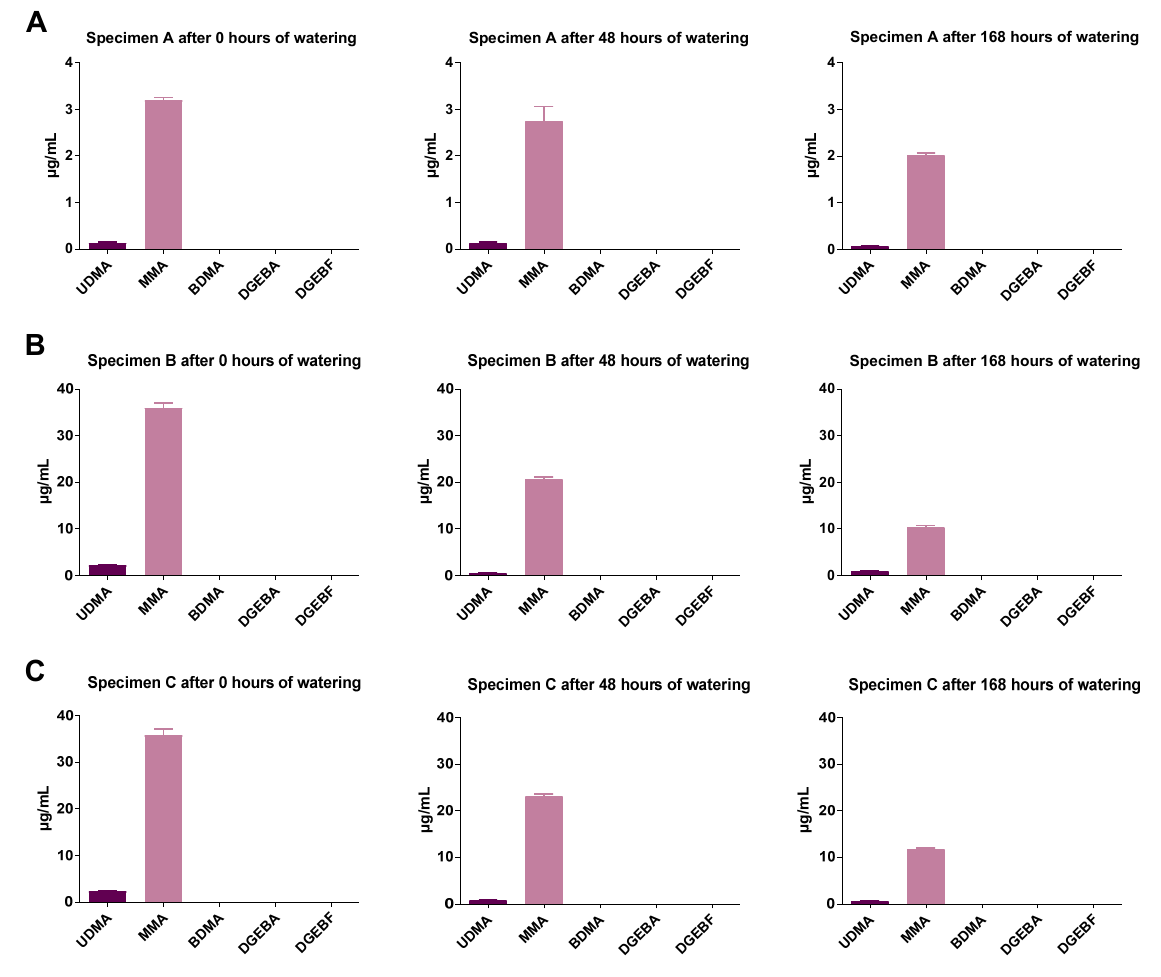
Figure 5. Monomer concentrations in Orthocryl ® specimen extracts of ( A ) test specimens A (15 mm × 0.5 mm), ( B ) test specimens B (50 mm × 1.0 mm) or ( C ) test specimens C (50 mm × 3.0 mm) under different soaking conditions. The test specimens were stored in distilled water at room temperature for 0, 48 or 168 h followed by a 24 h storage in cell culture medium (DMEM, Dulbecco’s Modified Eagle Medium) under shaking conditions. The DMEM eluates were used undiluted (100%) to determine the monomers by GC-MS. UDMA, urethane dimethacrylate; MMA, methyl methacrylate; BDMA, 1,4-butanediol dimethacrylate; DGEBA, bisphenol A diglycidyl ether; DGEBF, bisphenol F diglycidyl ether. The data are mean values ± SEM of n = 3–4 per group.